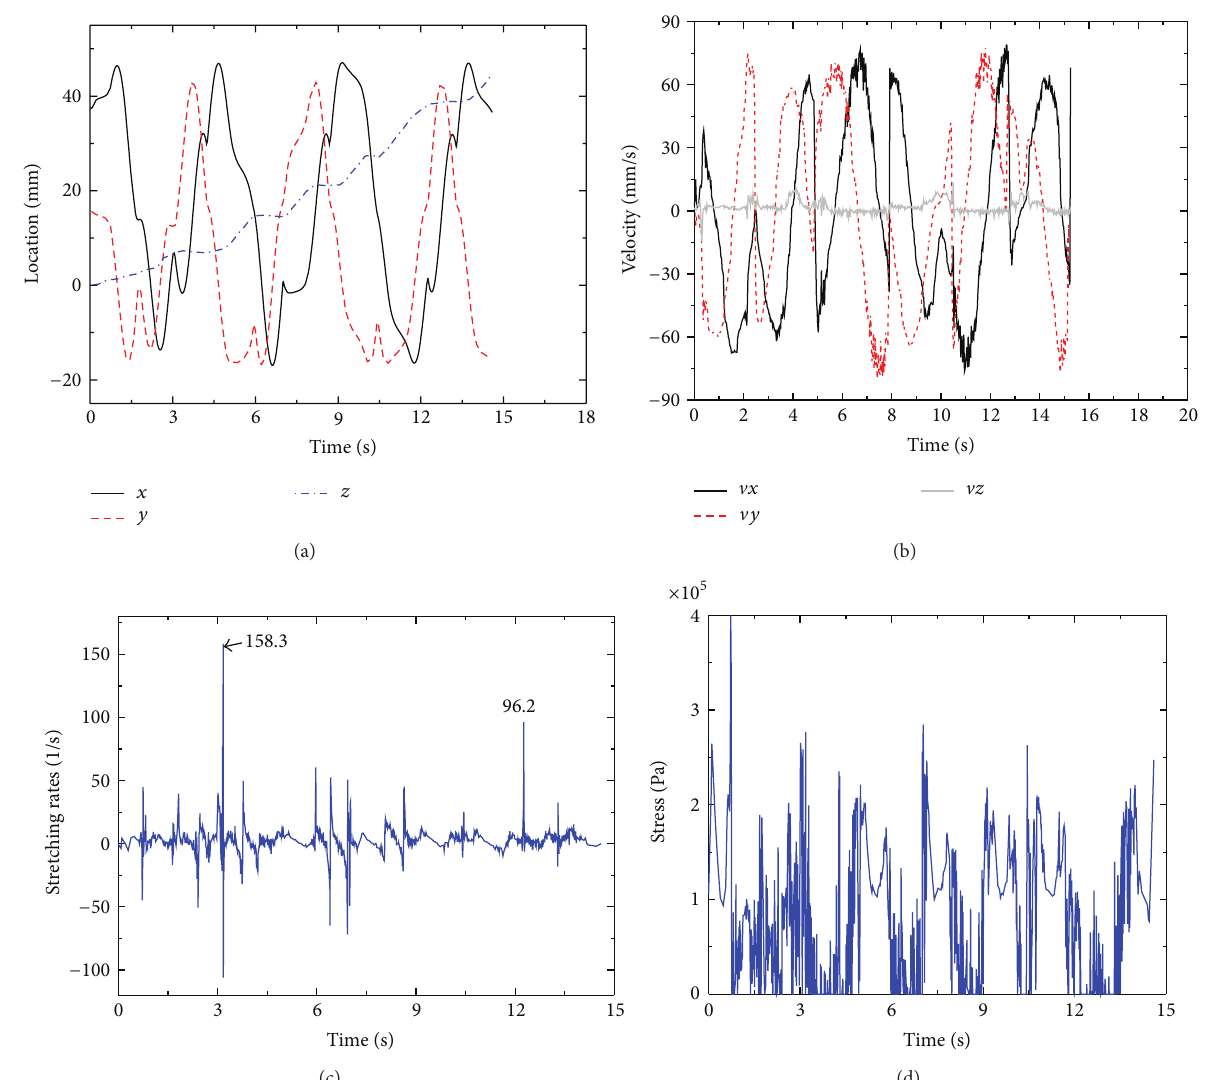
Figure 3: Periodical behaviors of Particle 1 in the tri-screw extruder: (a) displacement; (b) velocity; (c) stretching rate; (d) stress.